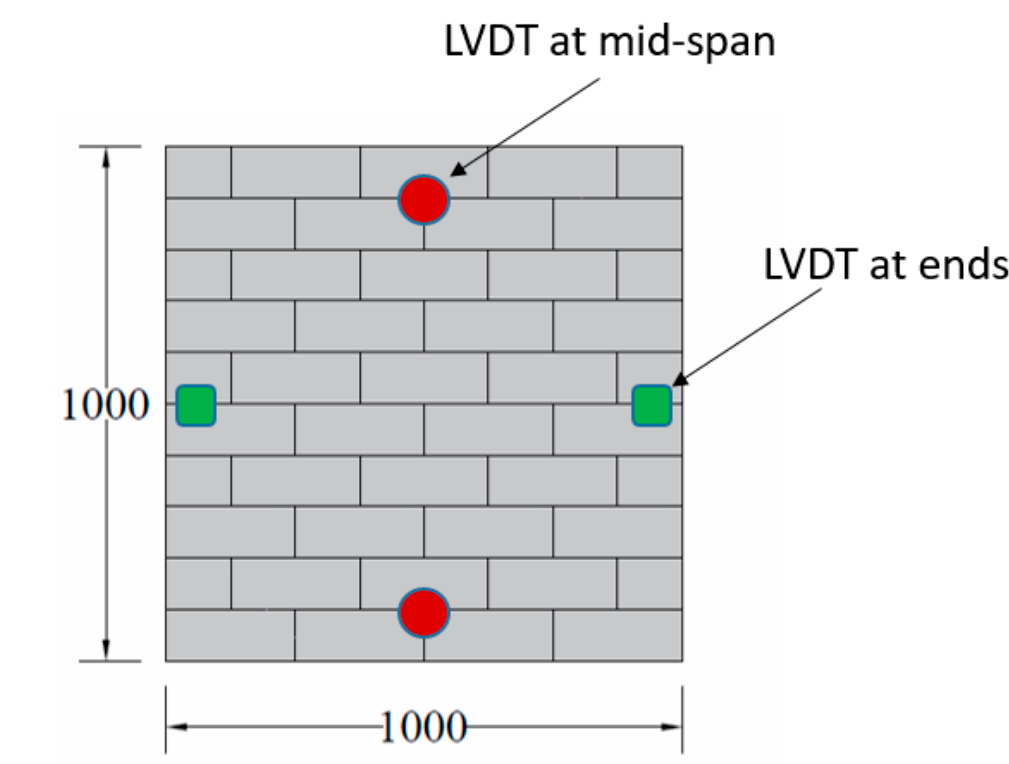
Figure 4. Details of LVDTs (units, mm).